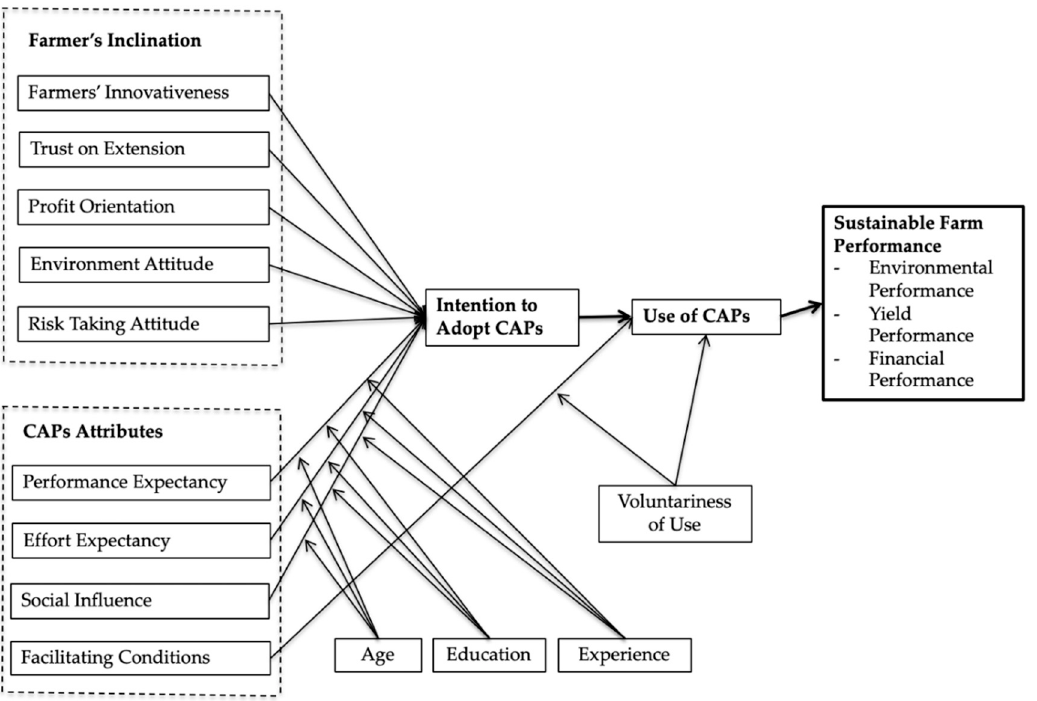
Figure 1. Research Model .